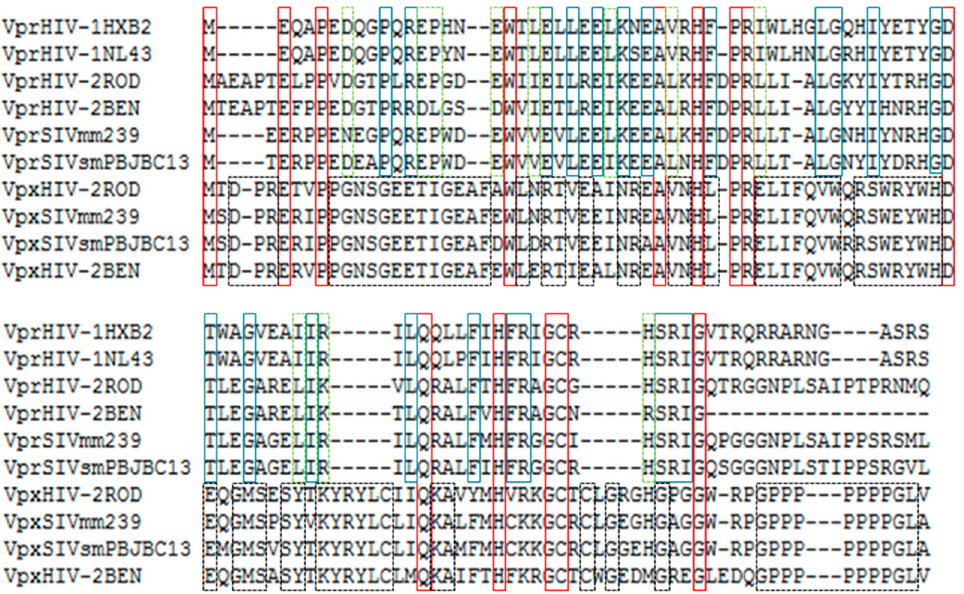
Figure 1. Amino acid sequence alignment of Vpr and Vpx proteins from human Immunodeficiency virus type 1 (HIV-1) and type 2 (HIV-2), and simian immunodeficiency viruses (SIV) using Fast Fourier Transform (MAFFT) at the EMBL-EBI server (available on 20 October 2016 http://www.ebi.ac.uk). Color code of amino acids within rectangles: red = fully conserved residues in all Vpr and Vpx proteins; blue = fully conserved residues only in Vpr proteins; dotted green = residues with similar properties in Vpr proteins; dotted black = fully conserved residues only in Vpx proteins.